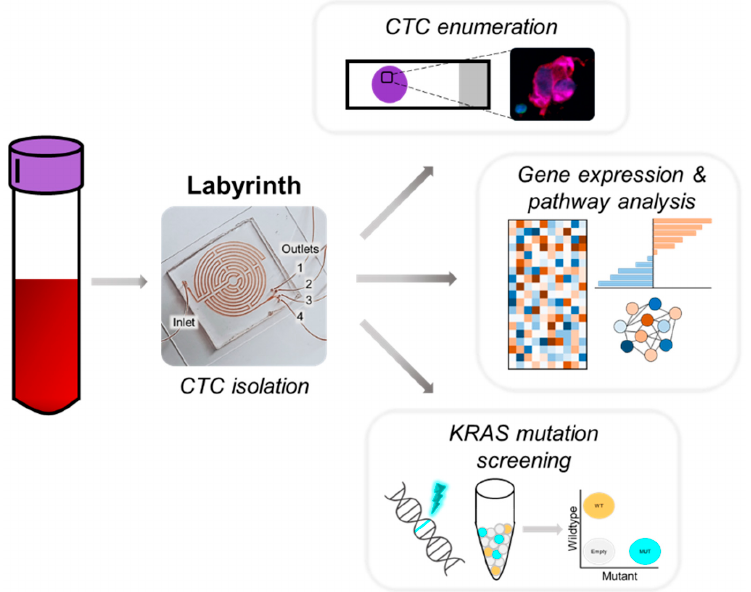
Figure 1. Multipronged CTC enumeration and transcriptome analysis from metastatic PDAC pa- tients.